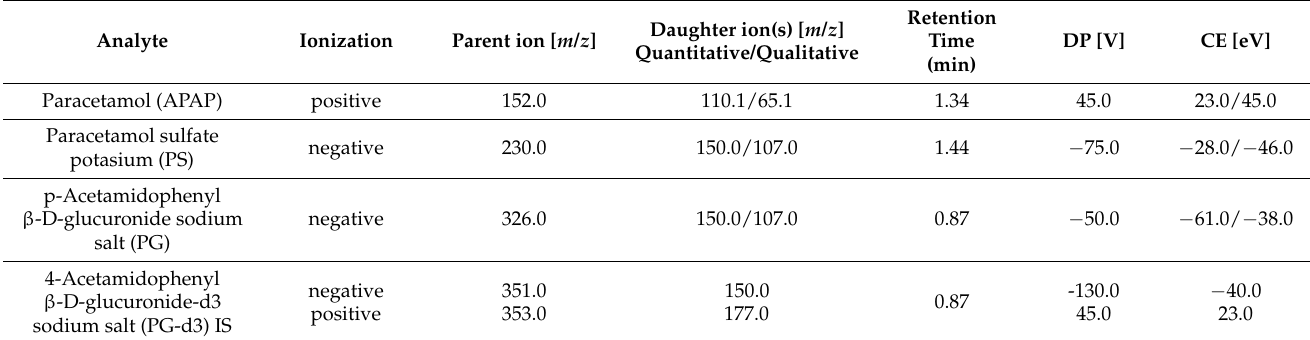
Table 1. Summary of the MRM monitored for analytes and MS/MS